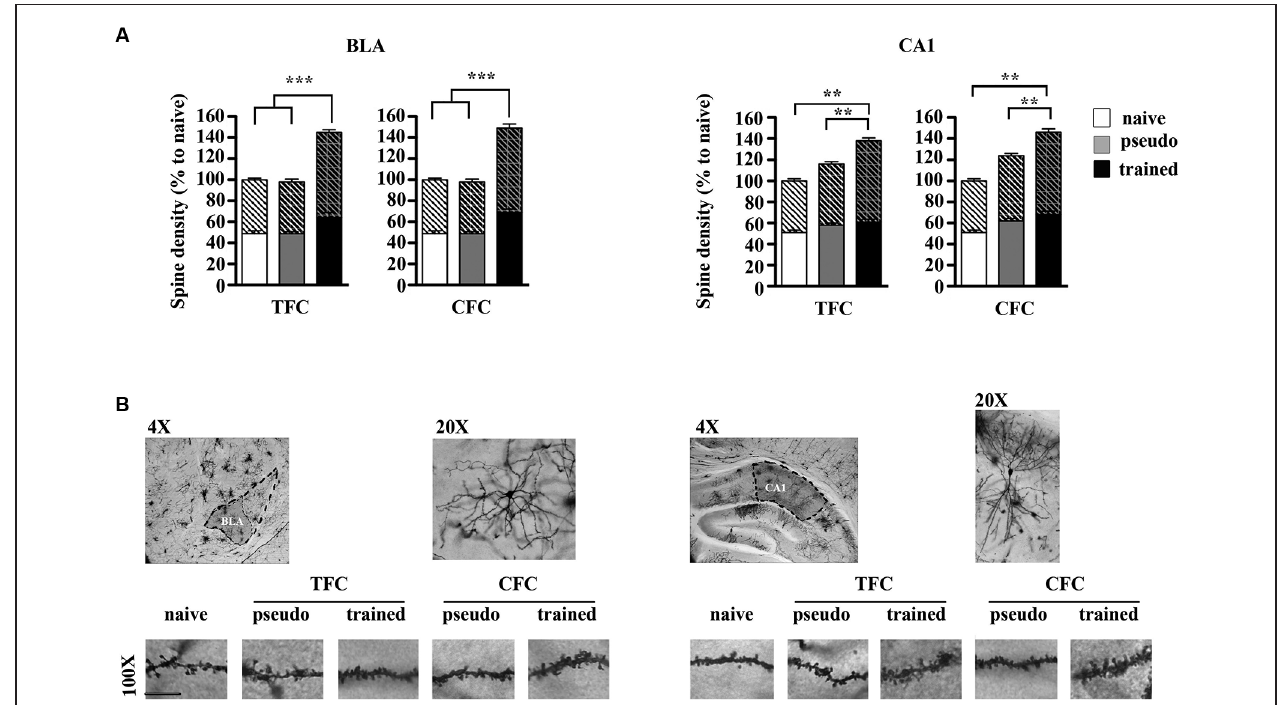
In the hippocampus, spine density was increased in both TFC- and CFC-trained mice compared to pseudo-trained and naïve mice, but also in CFC- and TFC- pseudo-trained mice compared to naïve mice (white bars: naïve mice; gray bars: pseudo-trained mice; black bars: trained mice). (B) Representative segments of BLA (left) and CA1 (right) dendrite segments taken from mice experiencing each